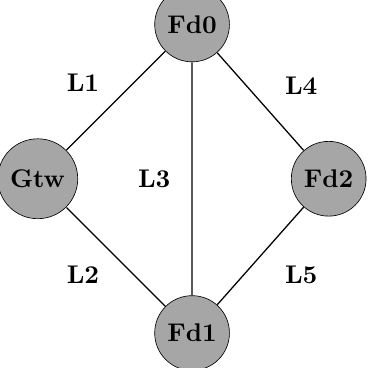
Figure 10. Topology used to exemplify the minimal cut set